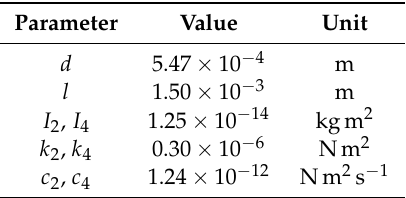
Table 2. Numerical values of the